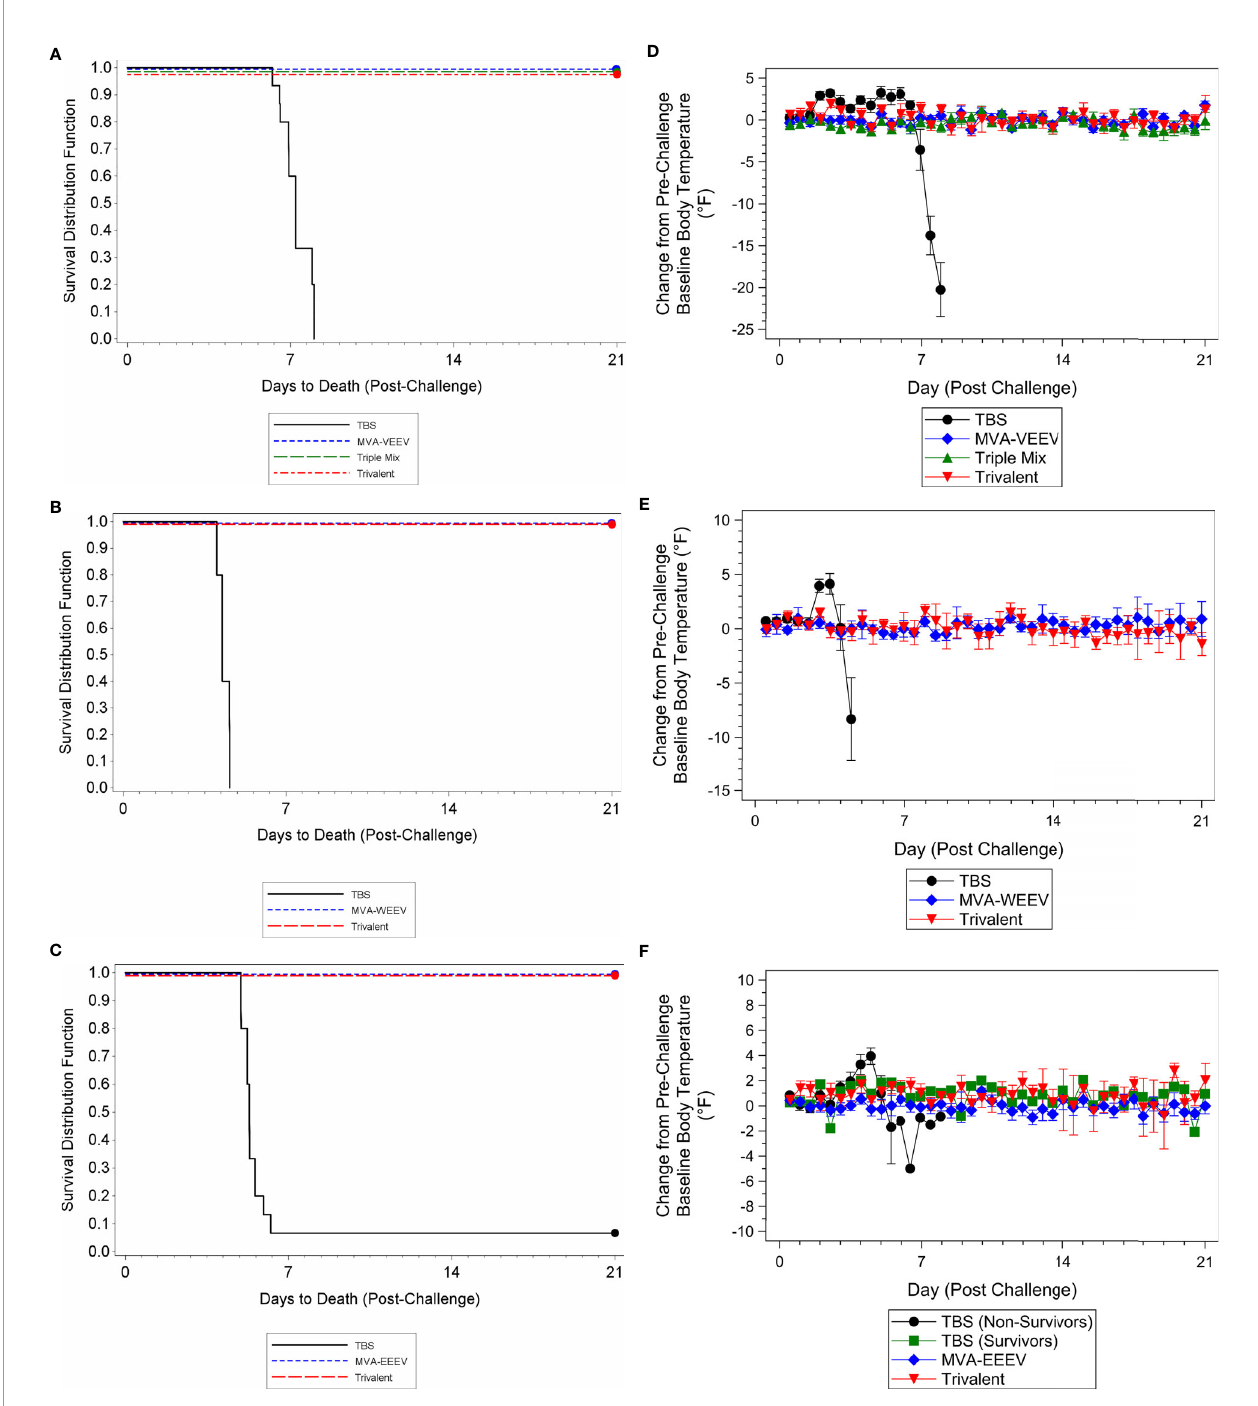
FIGURE 4 | Survival and Body Temperature Changes after VEEV INH-9813, WEEV Fleming, or EEEV V105-00210 Aerosol Challenge of Immunized Mice. Mice were immunized (IM) twice (Day 0 and 28) with the respective vaccine or TBS and then exposed to an aerosolized dose of VEEV, WEEV, or EEEV on Day 42. Kaplan- Meier survival curves of VEEV (A) , WEEV (B) , and EEEV (C) challenge results are shown. There was a signi fi cant difference in survival between the TBS group and the vaccination groups (p < 0.01). Group mean changes (with 95% con fi dence intervals) in body temperature for VEEV (D) , WEEV (E) , and EEEV (F) challenge groups during the post-challenge period are shown. TBS control group mean body temperatures were signi fi cantly greater than baseline (p < 0.05) over the fi rst week post-challenge. Ninety- fi ve percent con fi dence intervals are not included when number of animals was less than three. Ten animals per group were evaluated for survival and body temperature